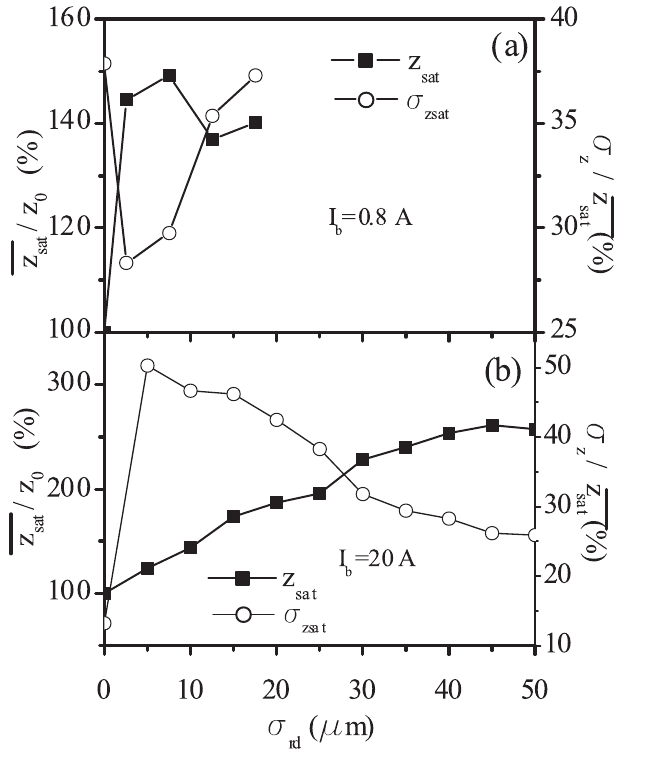
=z ) and nor- sat 0 =z ( (cid:6) ) as a function of the z sat sat for a weak pump rd FIG. 6. For the electron-beam current of 20 A, (a) average versus the frequency of the seed field for saturated power P sat (cid:3) 20 (cid:7) m and z (cid:3) liner fluctuations characterized by (cid:6) rd c versus (cid:6) for a 10 cm and (b) average saturated power P rd sat frequency of 40 GHz. In both graphs lines are for guidance.